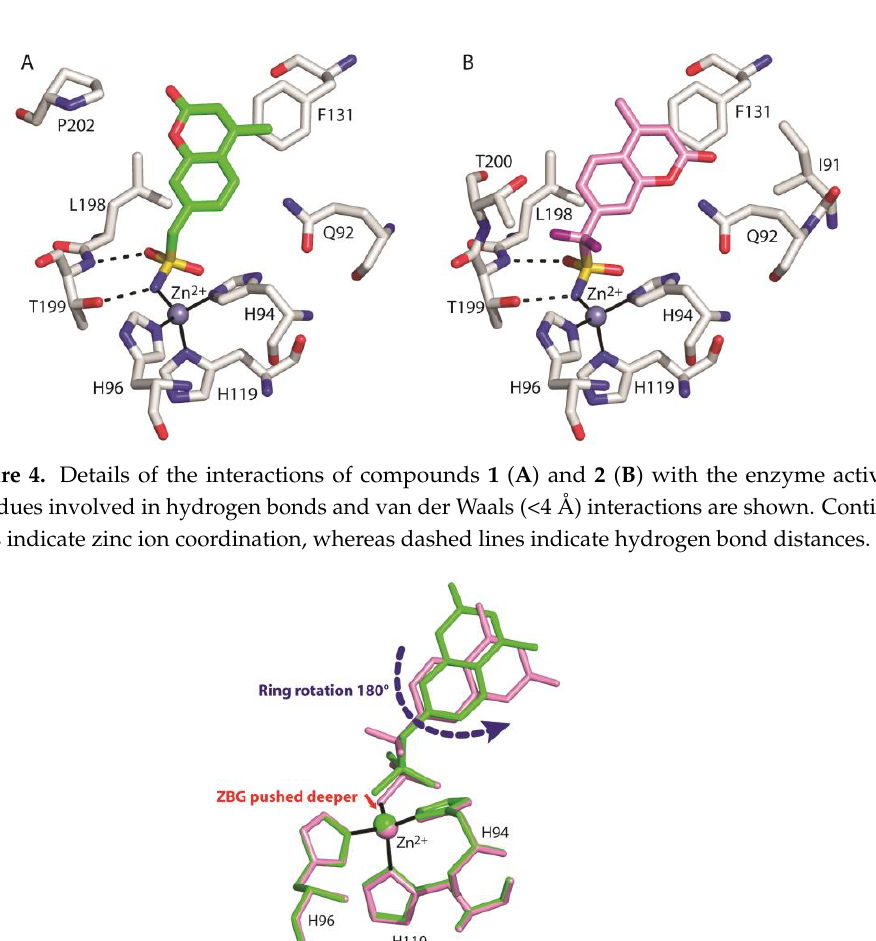
Figure 5. Structural superposition between compounds 1 (green) and 2 (pink) when bound to the hCA II active site.